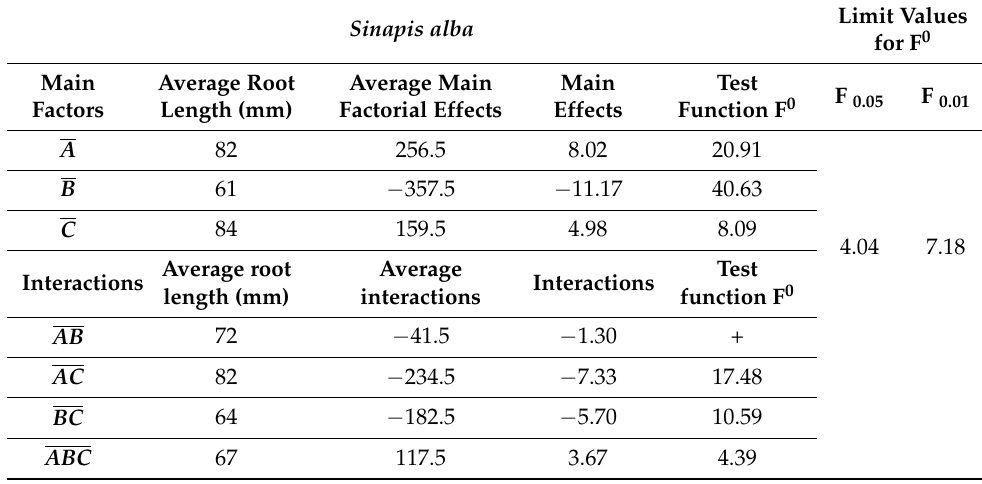
Table 11. Mean main factorial effects, average interactions, and their significance for Sinapis alba .